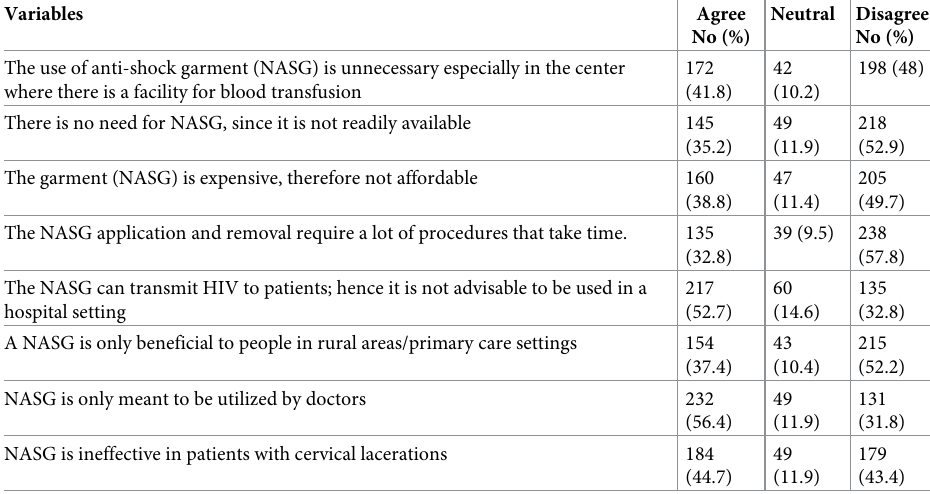
Table 4. Attitudes towards NASG utilization among obstetric care providers working in public health facilitates of southern Ethiopia, 2020. Variables